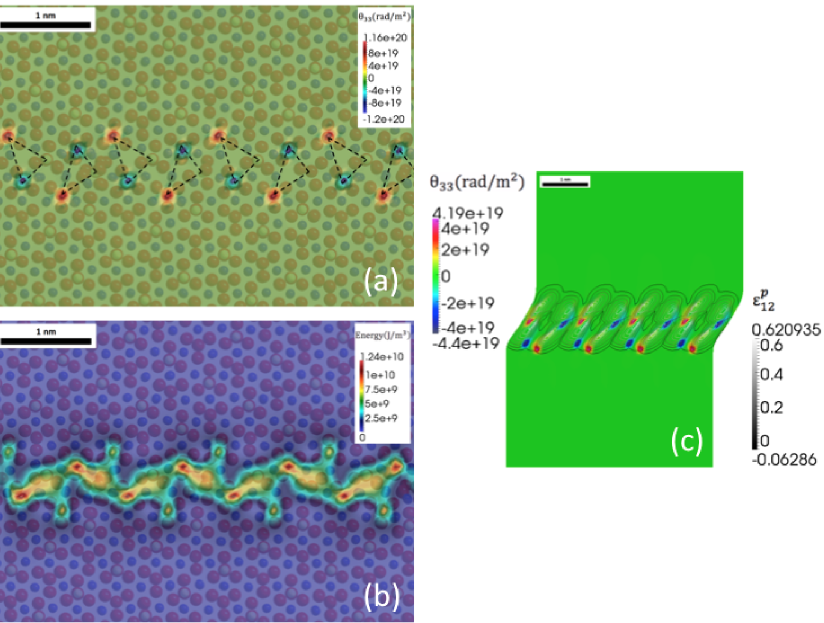
Figure 5. Disclination model for a (011)/<100>, 60 ◦ tilt boundary in forsterite. ( a ) Initial wedge-disclination density (rad · m − 2 ) superimposed on top of the atomic structure. Triangles show the structural units; ( b ) Elastic energy (J/m 3 ); ( c ) Migration of the (011)/<100> tilt boundary. The wedge-disclination density θ 33 (rad · m − 2 ) is shown in color. The plastic shear generated by migration is shown with gray